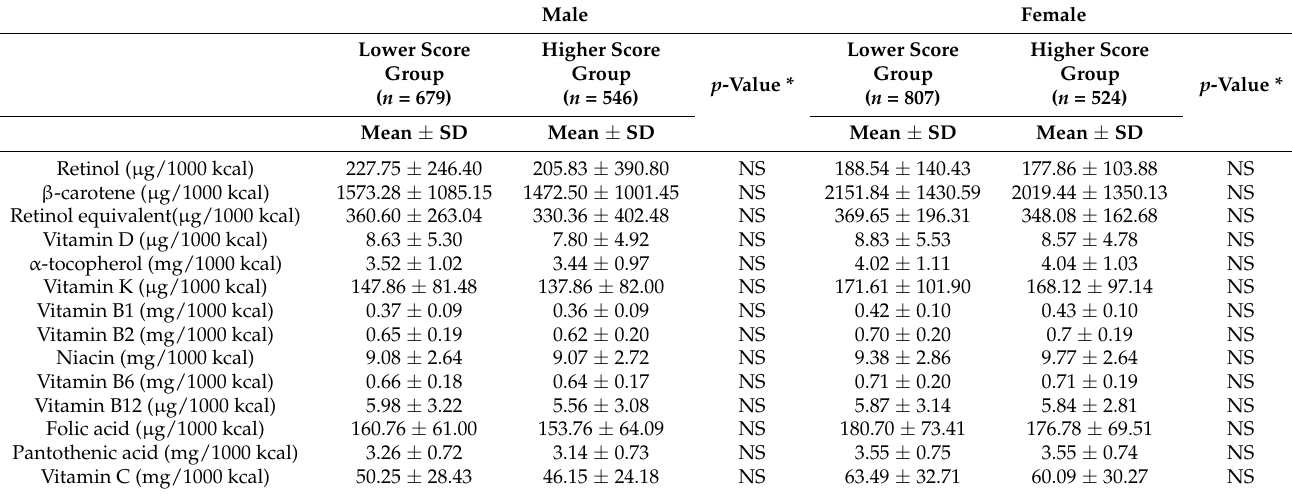
Table 4. Comparisons of the nutrient intakes according to Role Component Summary (RCS) groups.